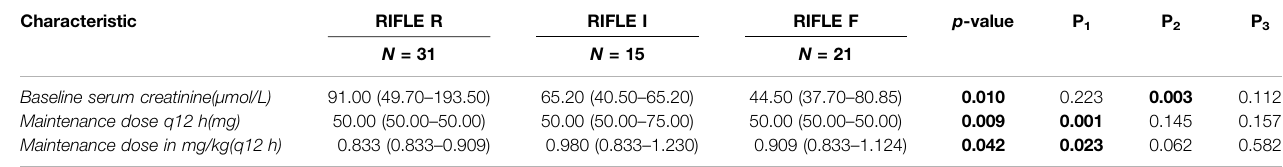
TABLE 4 | Factors potentially associated with the RIFLE classi fi cation of acute kidney injury in all patients treated with PMB. Characteristic RIFLE R RIFLE I RIFLE F p -value P 1 P 2 P 3 N = 31 N = 15 N = 21 Baseline serum creatinine( μ mol/L)